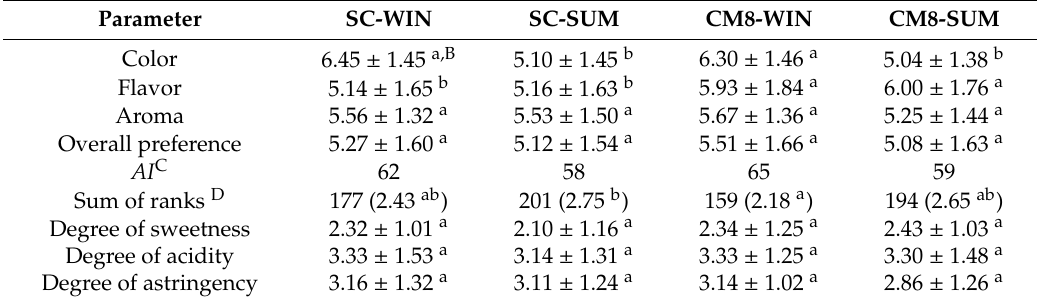
Table 3. Consumer acceptance and rank preference data for the red wines studied